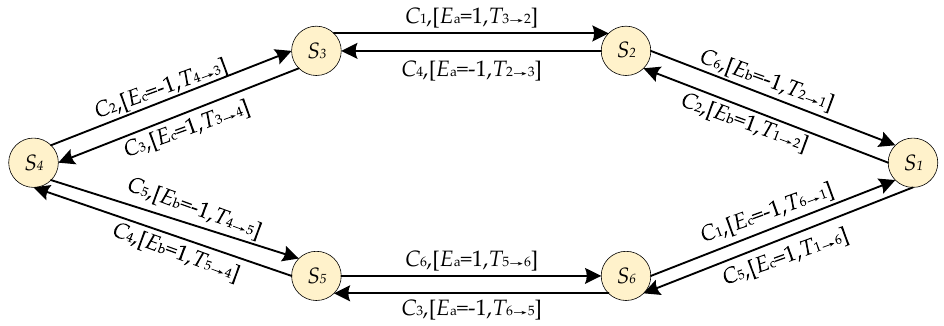
Figure 7. Normal extended finite state machine (EFSM) of the PMBLDC motor drive.